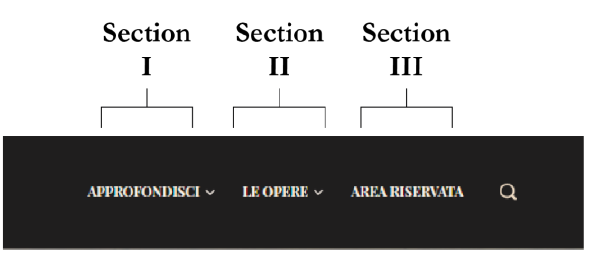
Fig 17. Website menus.